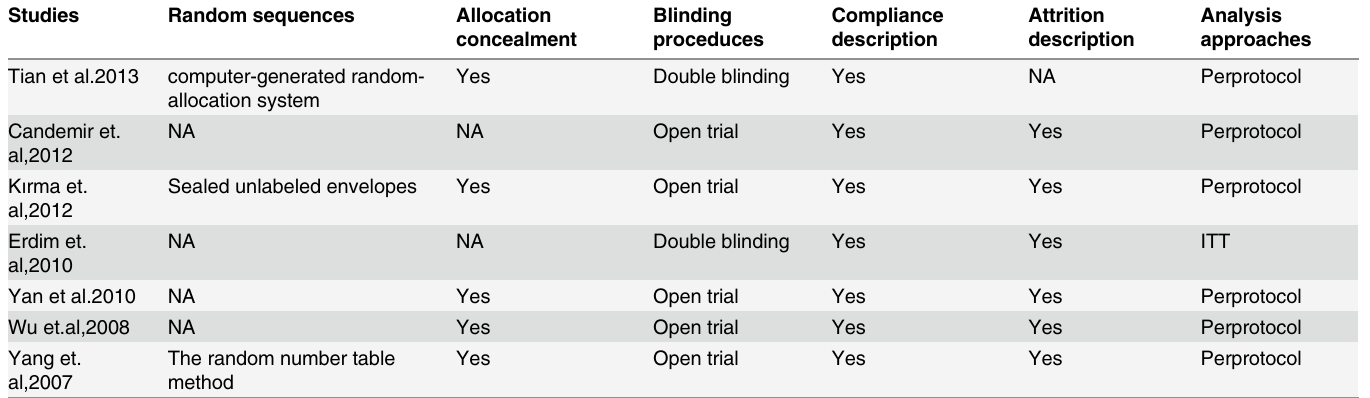
Table 1. Design characteristics of included studies.